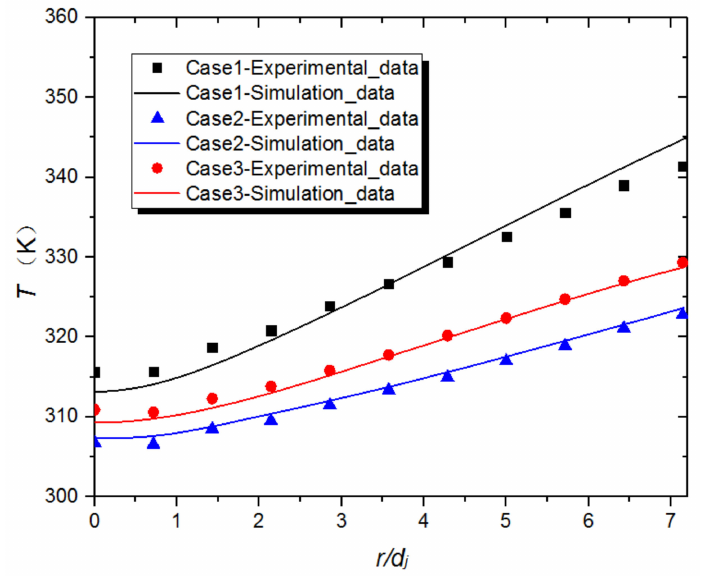
Figure 4. Comparison of calculated values of target surface temperature with experimental